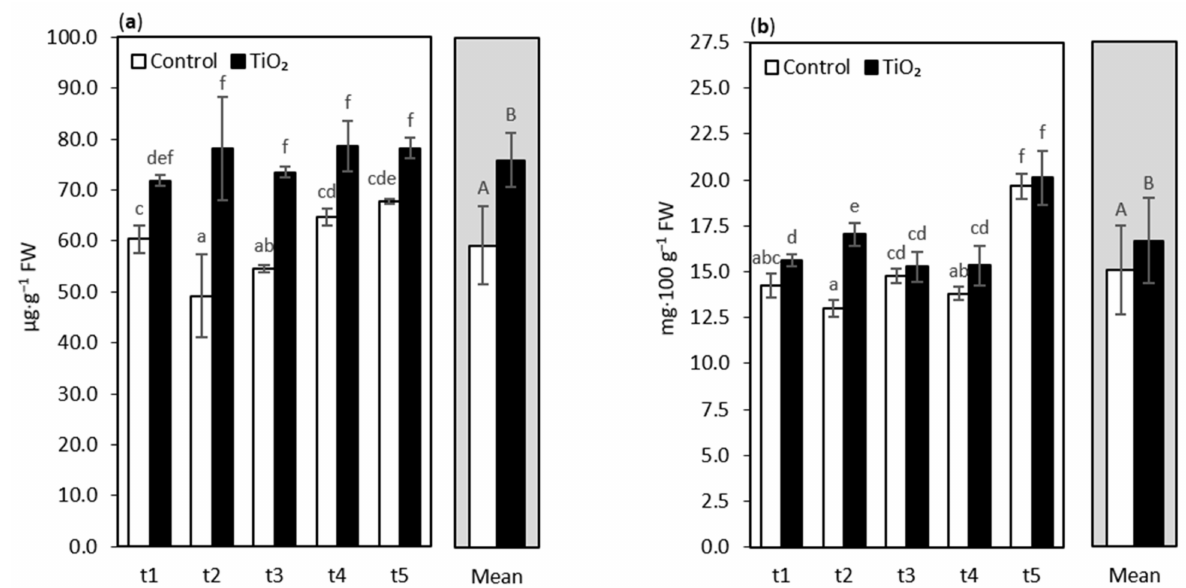
Figure 2. Glutathione (GSH) content ( a ) and L-ascorbic acid (AsA) content ( b ) of oakleaf lettuce seedlings treated with TiO 2 -NPs applied on the leaves as a 0.75% suspension, while the control plants were sprayed with deionized water. Plants were sampled 4, 7, 9, 11, and 13 days after treatment (sampling time: t1, . . . , t5, respectively). Lower-case letters above bars highlight significant differences for interaction effects, and capital letters indicate the differences between the means for the treatment groups (NPs treated plants and control plants), according to Fisher’s test ( p ≤ 0.05). Error bars represent standard deviations ( ±